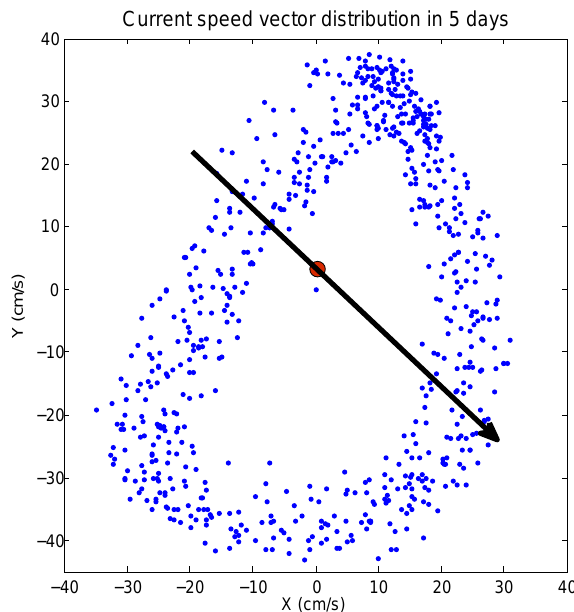
Figure 7: Tidal current speed distribution at location (N54 ◦ 59 (cid:48) 50 (cid:48)(cid:48) , E7 ◦ 54 (cid:48) 30 (cid:48)(cid:48) ) from 14/03/2006 to